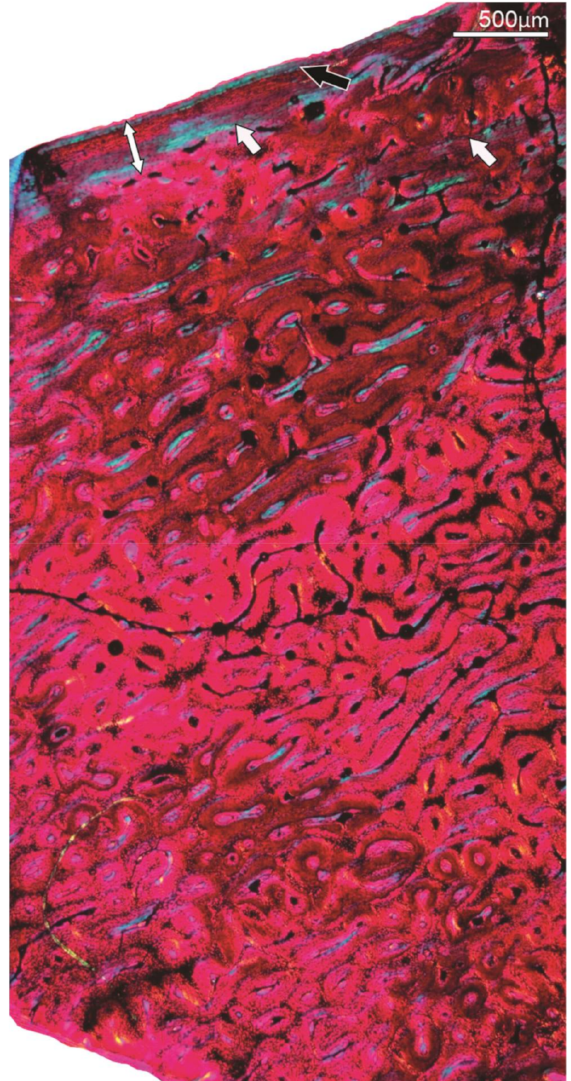
Figure 8. Specimen FU2750; Tarsometatarsus. Overview of the well-vascularised, primary compacta of the bone. In the peripheral region, a narrow OCL (double-headed arrow) and 2 narrow annuli (arrows) that precede it are visible. Subperiosteally, a LAG is present (black